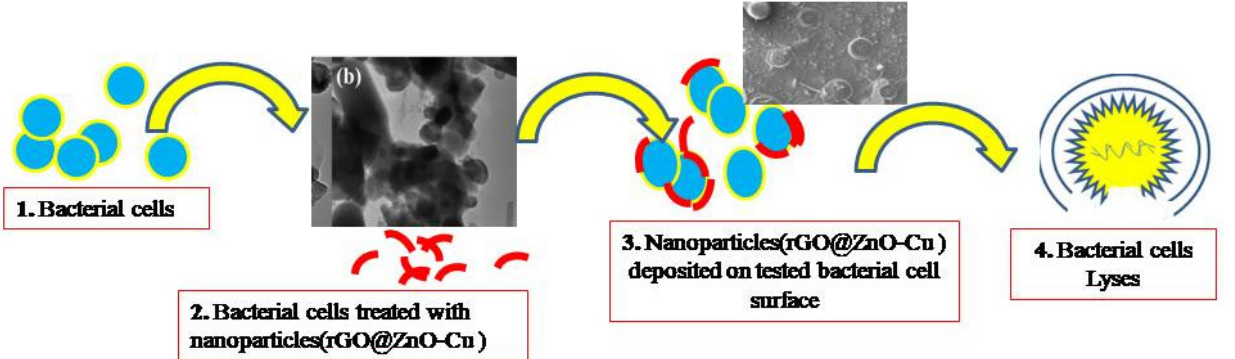
Figure 8. Conclusive steps from synthesis to interaction of rGO@ZnO–Cu with the S. aureus bacte- rial cells.